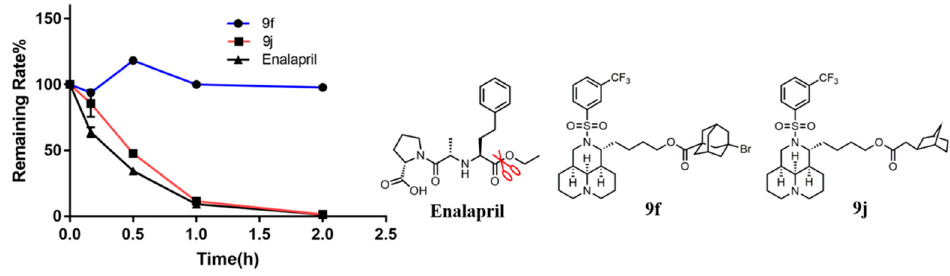
Figure 3. The stability assessments of key compounds 9f and 9j in whole blood. The dosing solutions were taken at 0, 1, 5, 10, 20, 40, 60, and 120 min, respectively, after the incubation of blood and tested samples at 37 °C in a water bath.